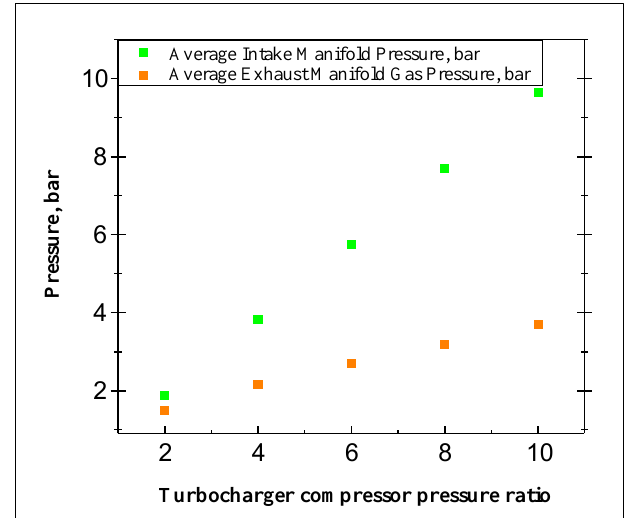
Figure 6. Intake and exhaust average manifold pressure